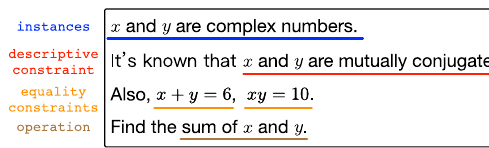
Fig. 4 Parsing the text into nodes in